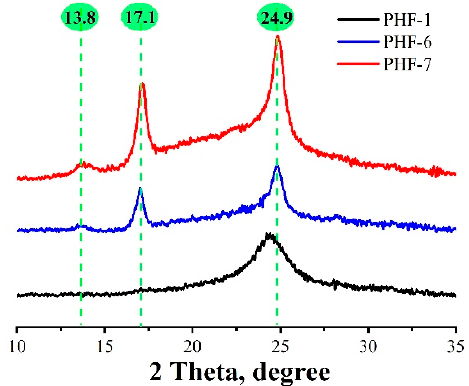
Figure 4. X-ray diffractograms of PHF-1, 6, and 7.